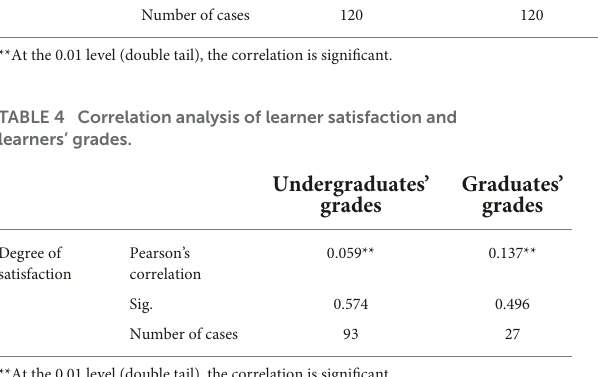
TABLE 5 Correlation analysis of learner satisfaction and frequency of exposure to courses using the AI